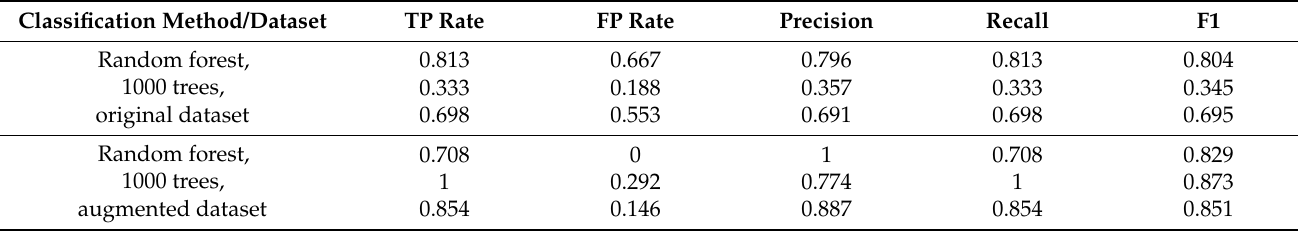
Table 17. Precision and recall analysis for the original and augmented